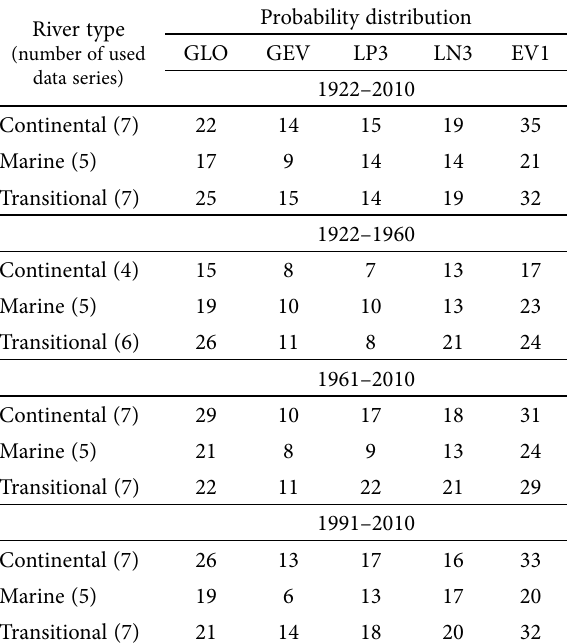
Figure 6 visualisation of the probability distribution fitting